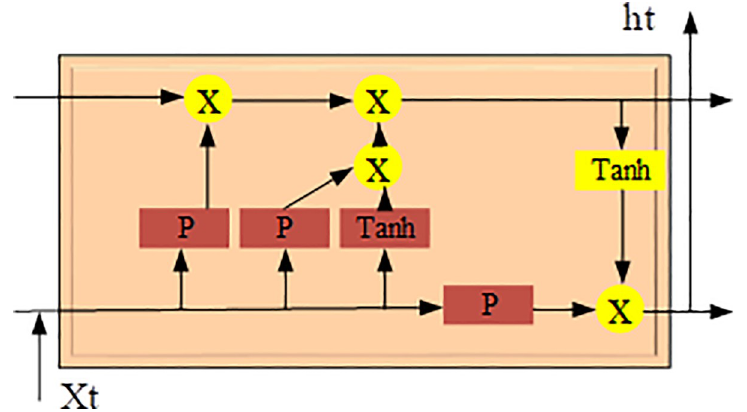
Fig 4. Structure diagram of convolution neural target tracking in table